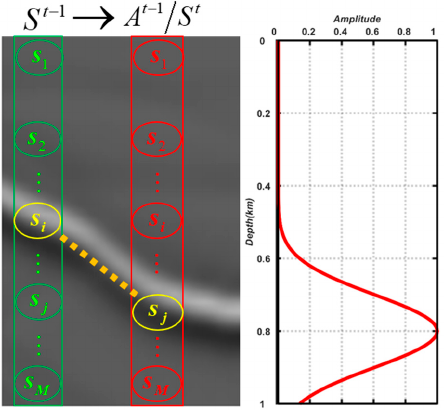
Figure 2. The diagram of the mapping process of the state to action. The background profile in the left figure is a local seismic image. The right figure shows the probability distribution followed by the relationship between state and action where the position of the current state at the time t − 1 is located at s i , and the state will move to next time t . The yellow dashed line is the direction corresponding to the dip angle calculated at the position s i . The probability at s j is maximum. Away from s j , the probability is getting smaller.